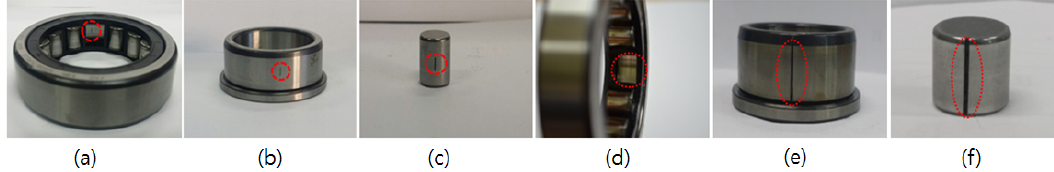
Figure 4. Faulty bearing parts with different crack severities. ( a ) BCO (bearing crack on the outer